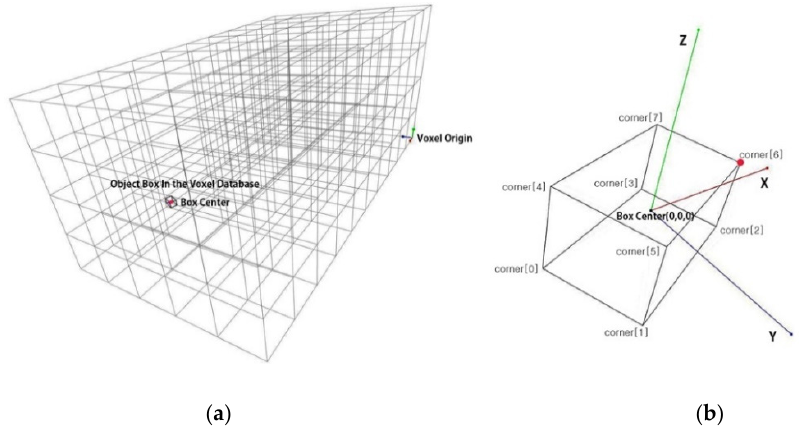
Figure 3. The Voxel database in the point cloud comprises ( a ) voxel grids and ( b ) corners of a box.